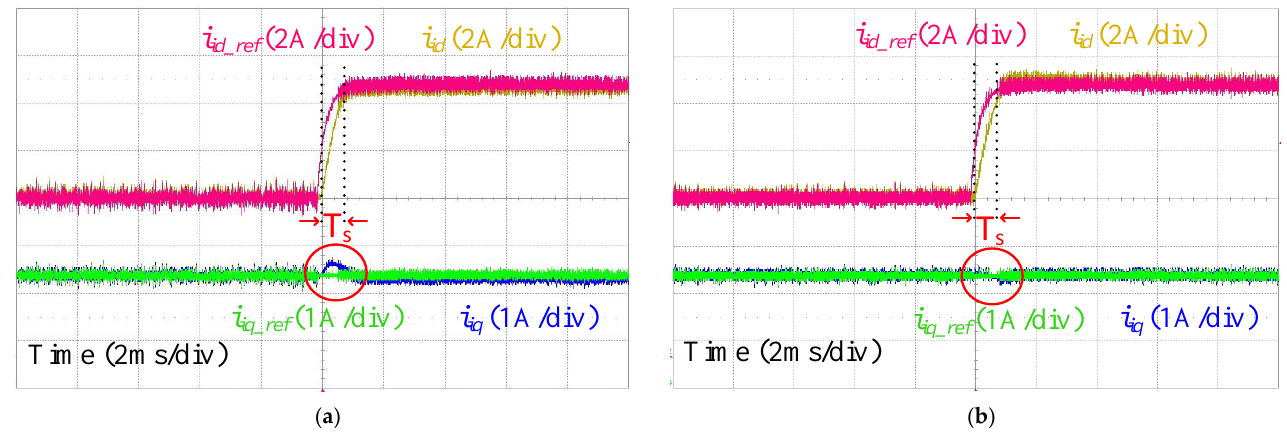
Figure 20. Current tracking i id and i iq for L filter type GcI with L grid = 0 ( a ) single-loop PI control; ( b ) RESO-based ADRC.